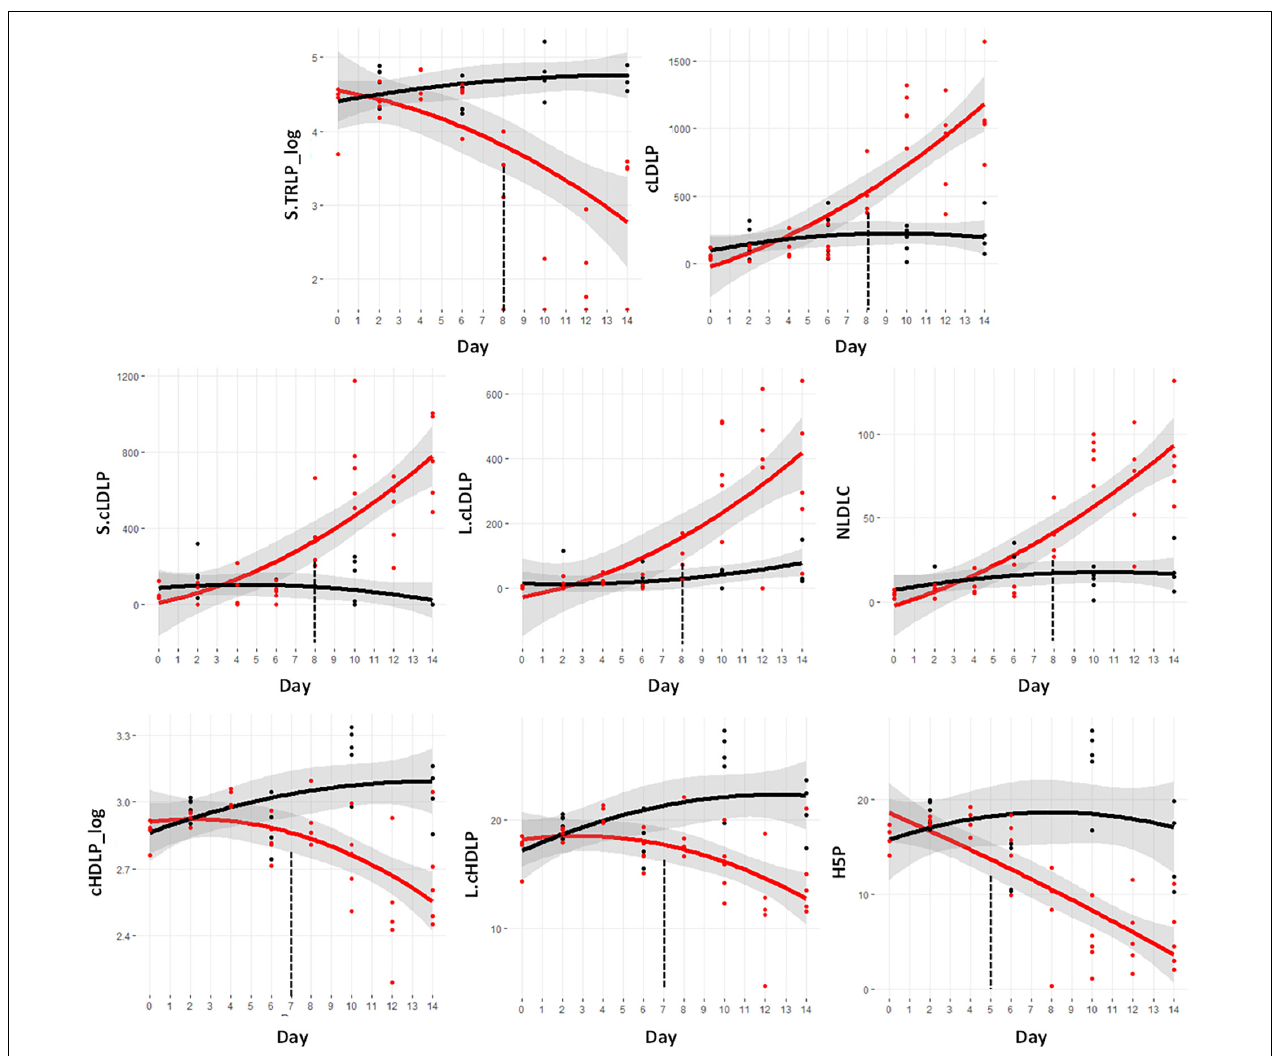
FIGURE 5 | Trajectory of lipoprotein measurements that were statistically significantly different prior to the significant weight loss at day 9. Black indicates control mice, red indicates cachectic mice, and the vertical dashed lines indicate the day in which the data were first significantly different. S.TRLP, small triglyceride rich particles (i.e., very low density lipoproteins); cLDLP, calibrated low density lipoprotein particles (nmol/L); S.cLDLP, small calibrated low density lipoprotein particles (nmol/L); L.cLDLP, large calibrated low density lipoprotein particles (nmol/L); NLDLC, cholesterol fraction of LDL particles (mg/dL); cHDLP_log, log transformed values of the calibrated total high density lipoprotein particles ( µ mol/L); L.cHDLP, large calibrated high density lipoprotein particles ( µ mol/L); HP5, cHDLP subspecies with particle size = 10.3 nm ( µ